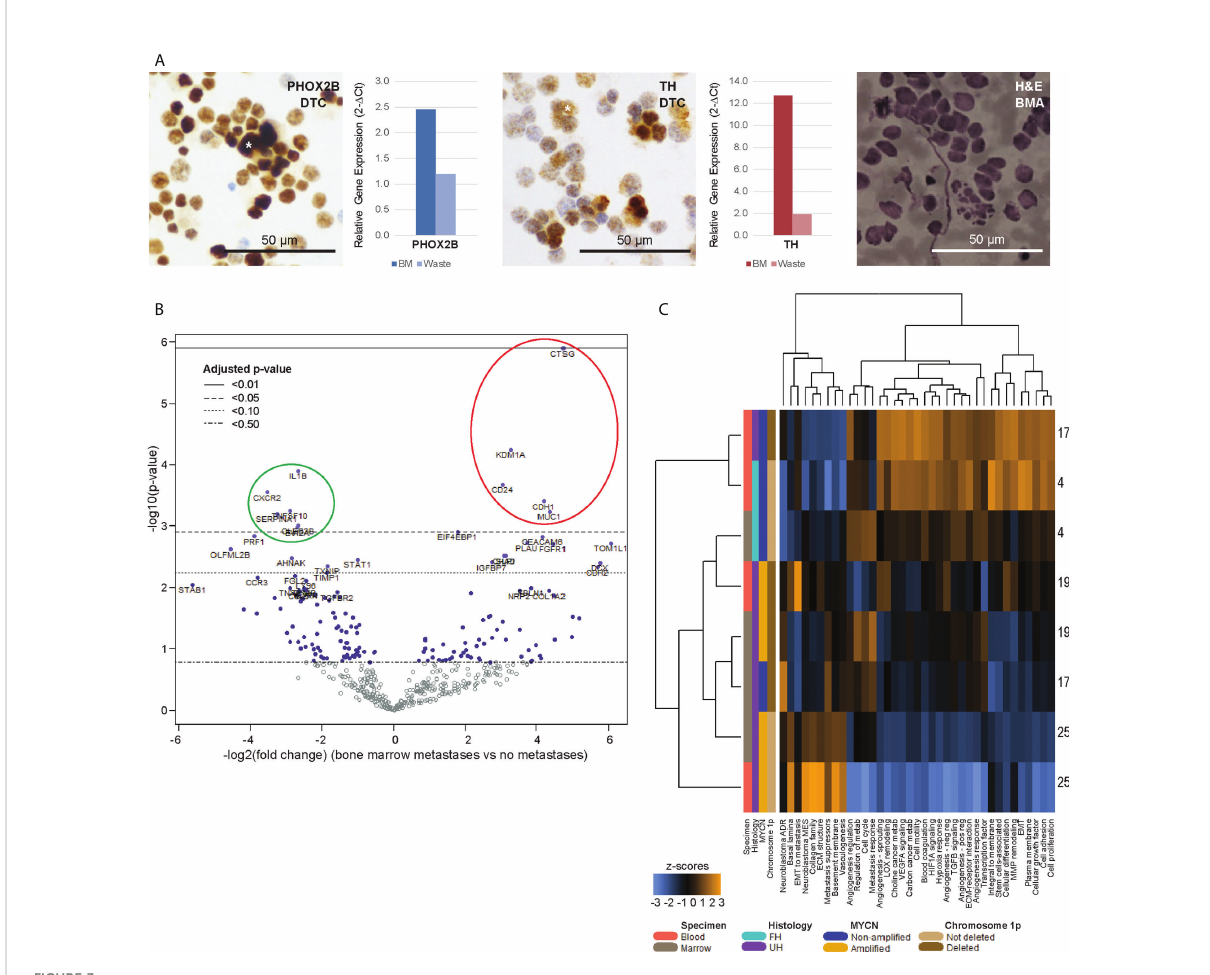
FIGURE 3 Bone marrow DTCs are isolated by size-based separation and express unique differentially expressed genes. (A) Representative photomicrographs of cytospots of DTC-enriched fractions from bone marrow aspirates of a patient with known bone marrow metastasis (NB9), showing nuclear immunoreactivity for PHOX2B and cytoplasmic staining for TH (asterisks). Corresponding relative gene expression of PHOX2B and TH in DTC-enriched bone marrow (BM) and waste fractions are shown alongside, as well as photomicrograph of BM aspirate showing in fi ltrating neuroblastoma tumor cells for size comparison (NB9, H&E, scale bar: 50 µm). (B) Volcano plot of genes from the PanCancer Progression Panel that were signi fi cantly upregulated (red) and downregulated (green) in bone marrow DTCs, compared to peripheral blood CTCs, in patients with known bone marrow metastases. Adjusted p-values are derived using Benjamini-Hochberg correction. Dot colors and reference lines indicate corresponding adjusted p-value thresholds. (C) Heatmap of signature scores of genes from the PanCancer Progression Panel in paired CTC and DTC samples from 4 patients with known bone marrow metastases, on unsupervised non-hierarchical